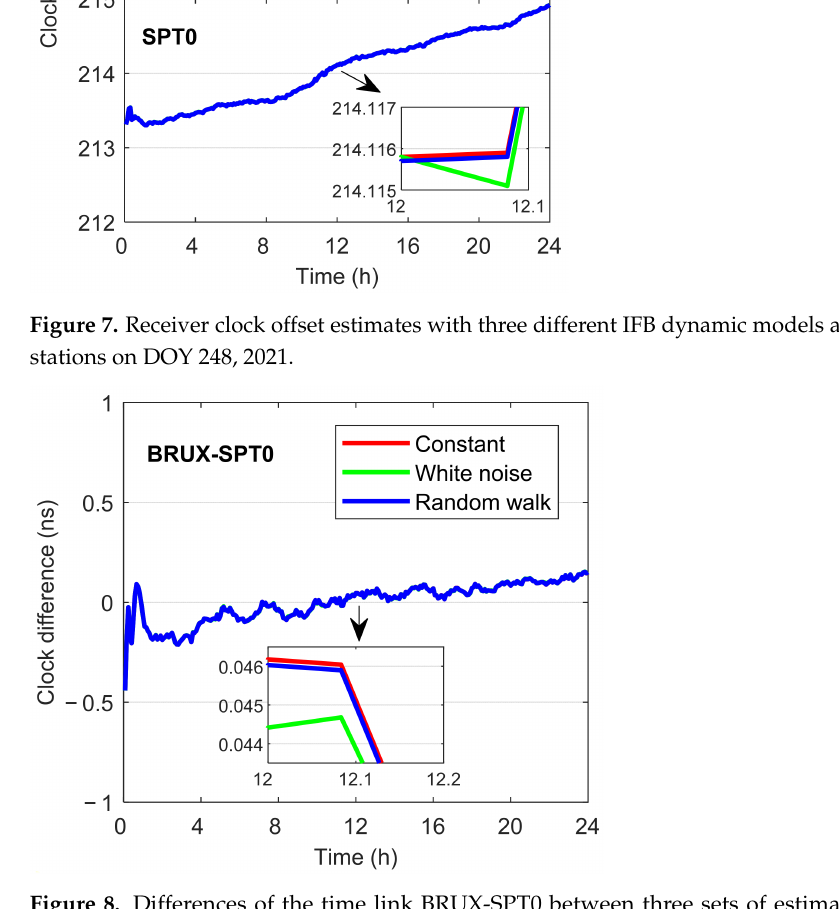
Figure 8. Differences of the time link BRUX-SPT0 between three sets of estimates and IGS final products on DOY 248,